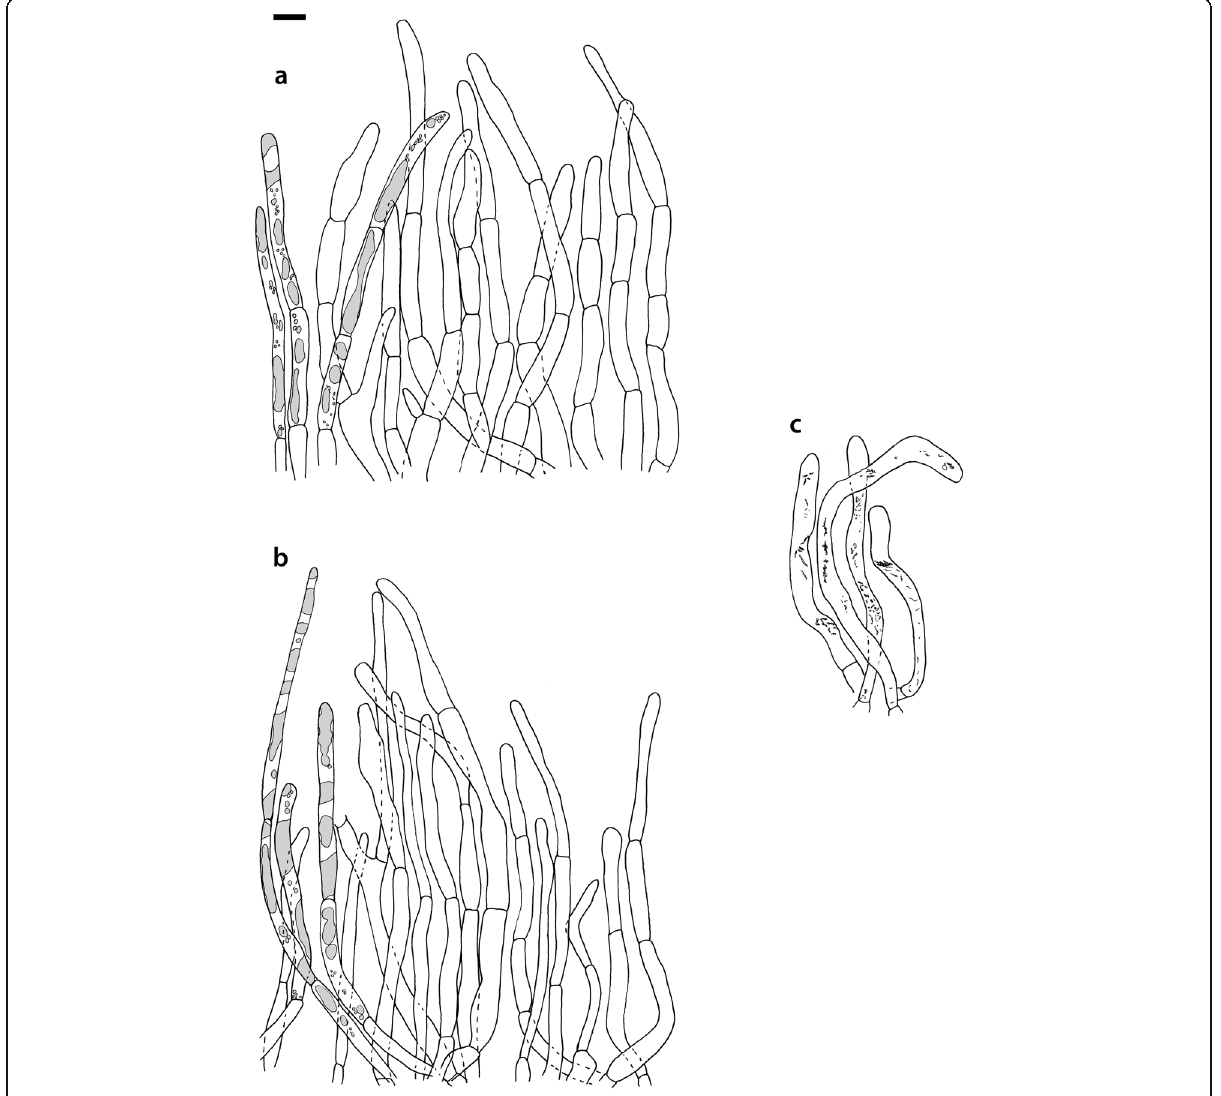
Fig. 15 Russula ustulata (AV 16 – 019), pileipellis. a Hyphal terminations near the pileus margin. b Hyphal terminations near the pileus centre. c Pileocystidia near the pileus margin. Bar = 10 μ